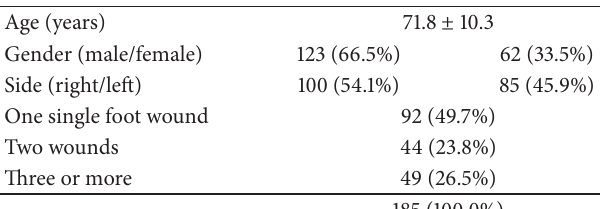
Table 1: Diabetic feet with peripheral arterial disease ( 𝑛 = 185 ).